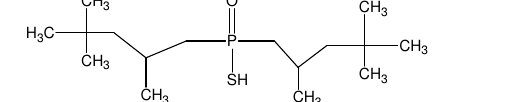
Figure 1. Structure of bis(2,4,4-trimethylpentyl)monothiophosphinic acid or